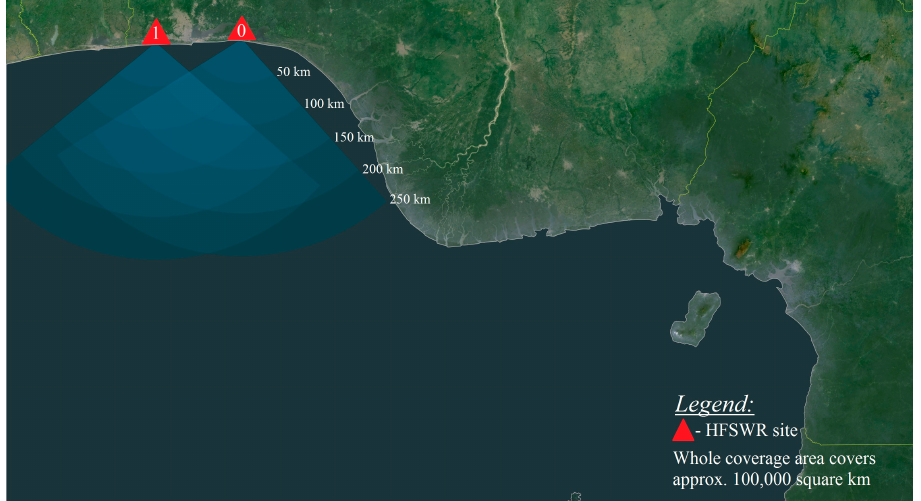
Figure 1. HFSWR network coverage area (taken from [21]).